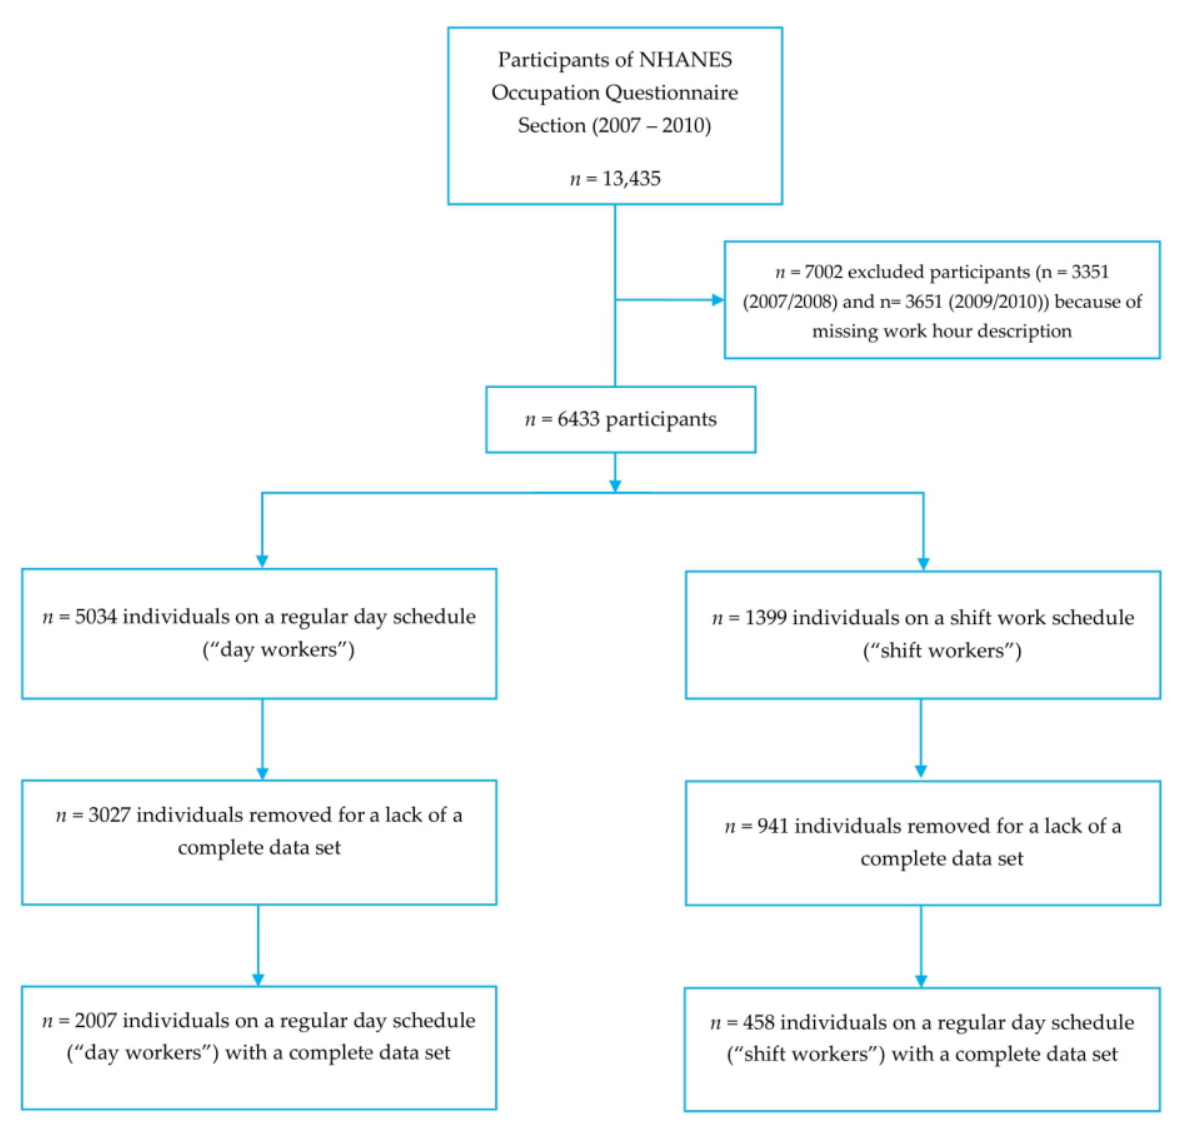
Figure 2. Inclusion flow chart: NHANES